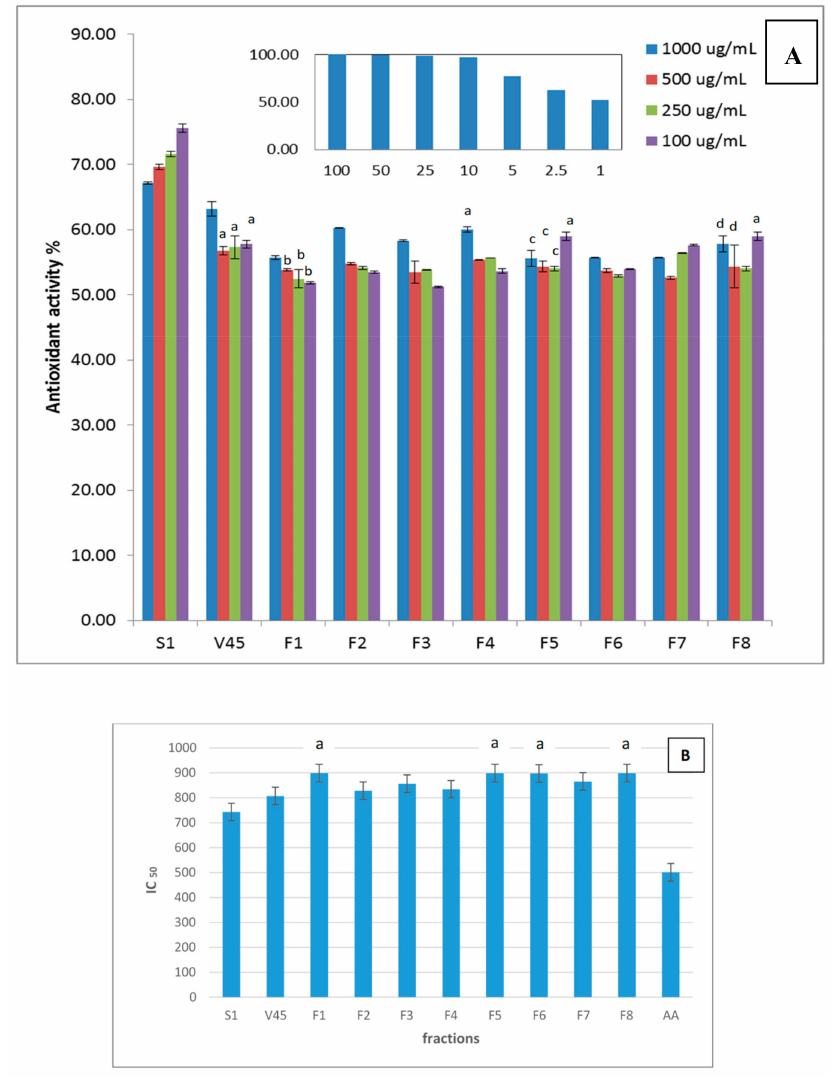
Figure 2. ( A ) Antioxidant activities of the column e ffl uent fractions at di ff erent concentrations, along with those of the mother S1 extract and the enzymatically hydrolyzed extract V45. The figure inset shows the activity of ascorbic acid at di ff erent concentrations. Sets with the same letters have insignificantly di ff erent values at p = 0.05. ( B ) Relevant IC50